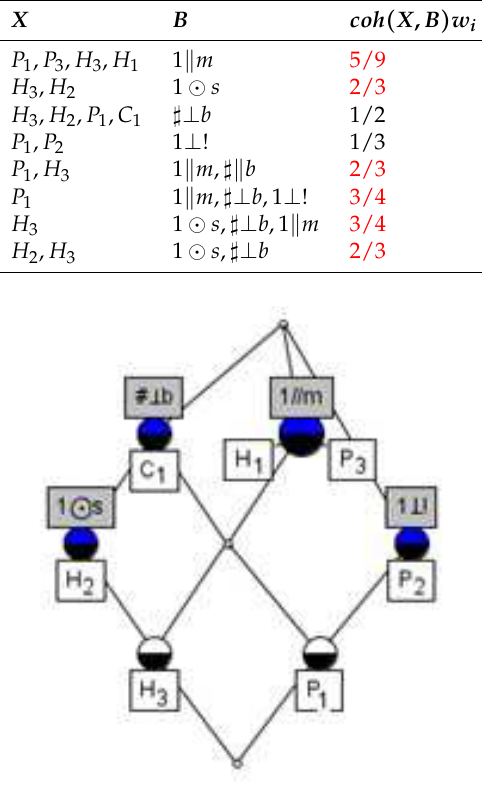
Figure 13. The concept lattice of Table